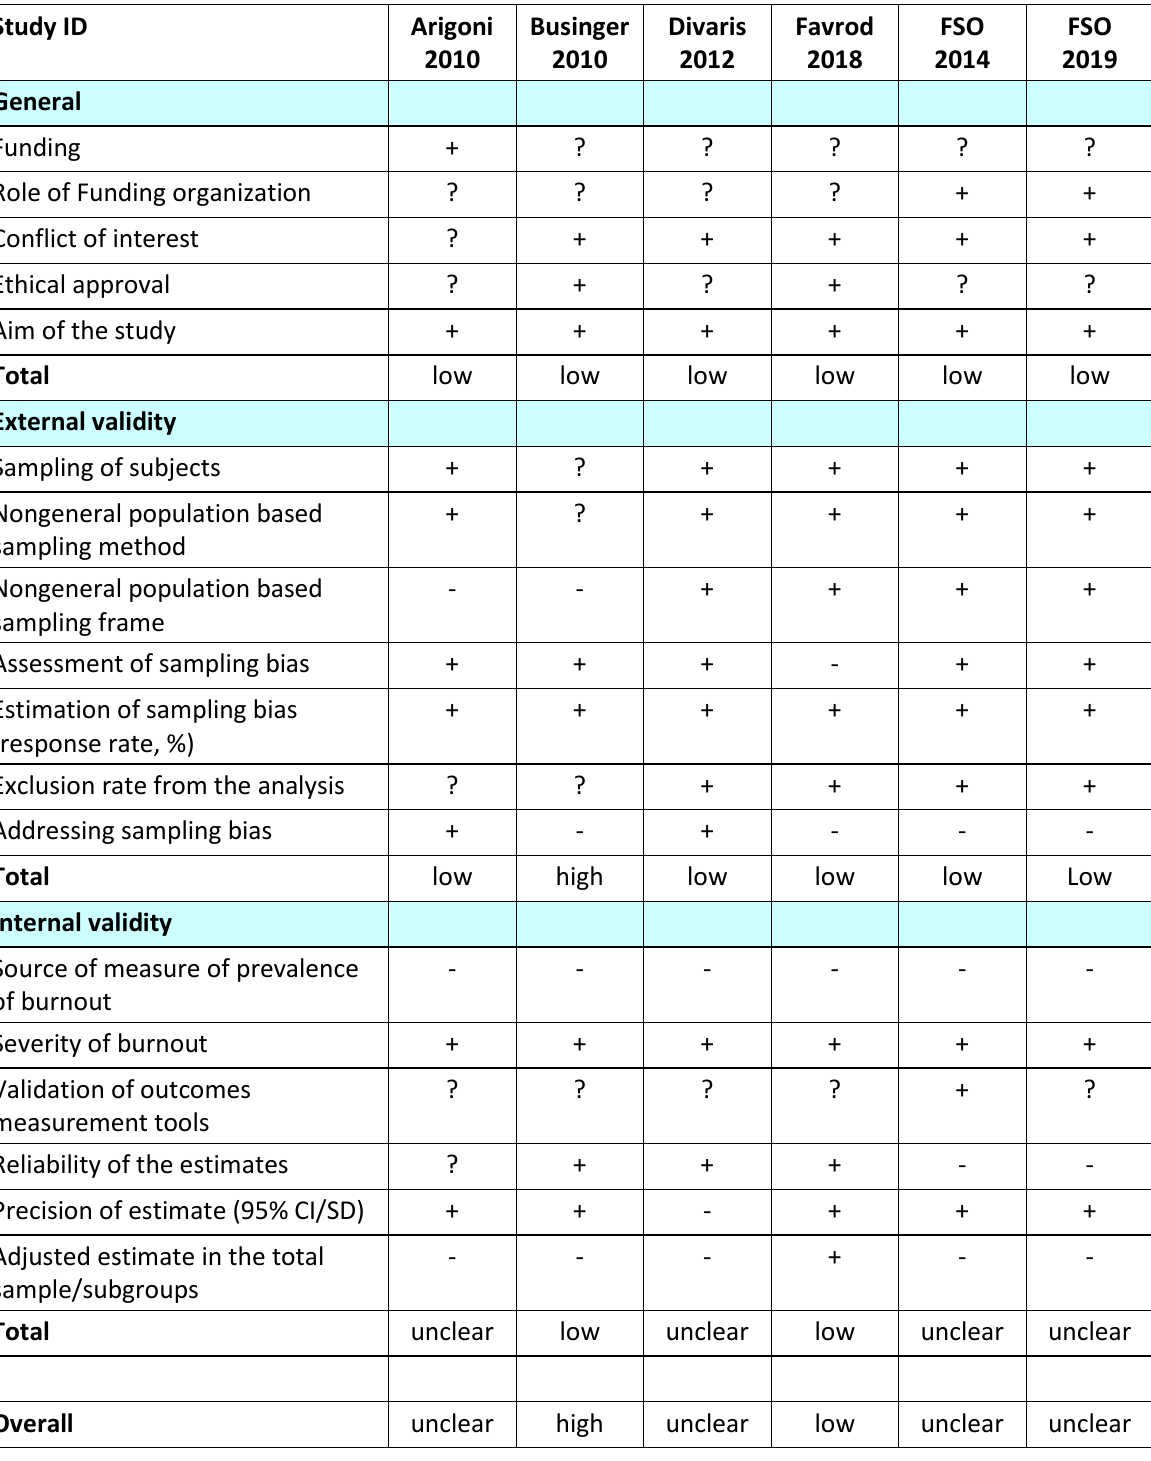
Table S1. Risk of bias assessment for included studies using MORE